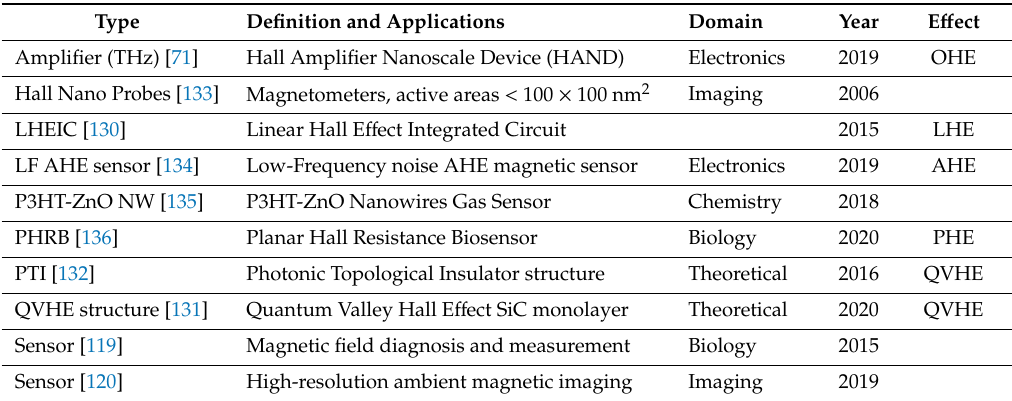
Table 3. Alphabetical summary table of the main known nano devices and structures with integrated Hall E ff ect. Classification is per device acronym and function. One can observe how few are the nanoscale devices when compared to their macro and micro